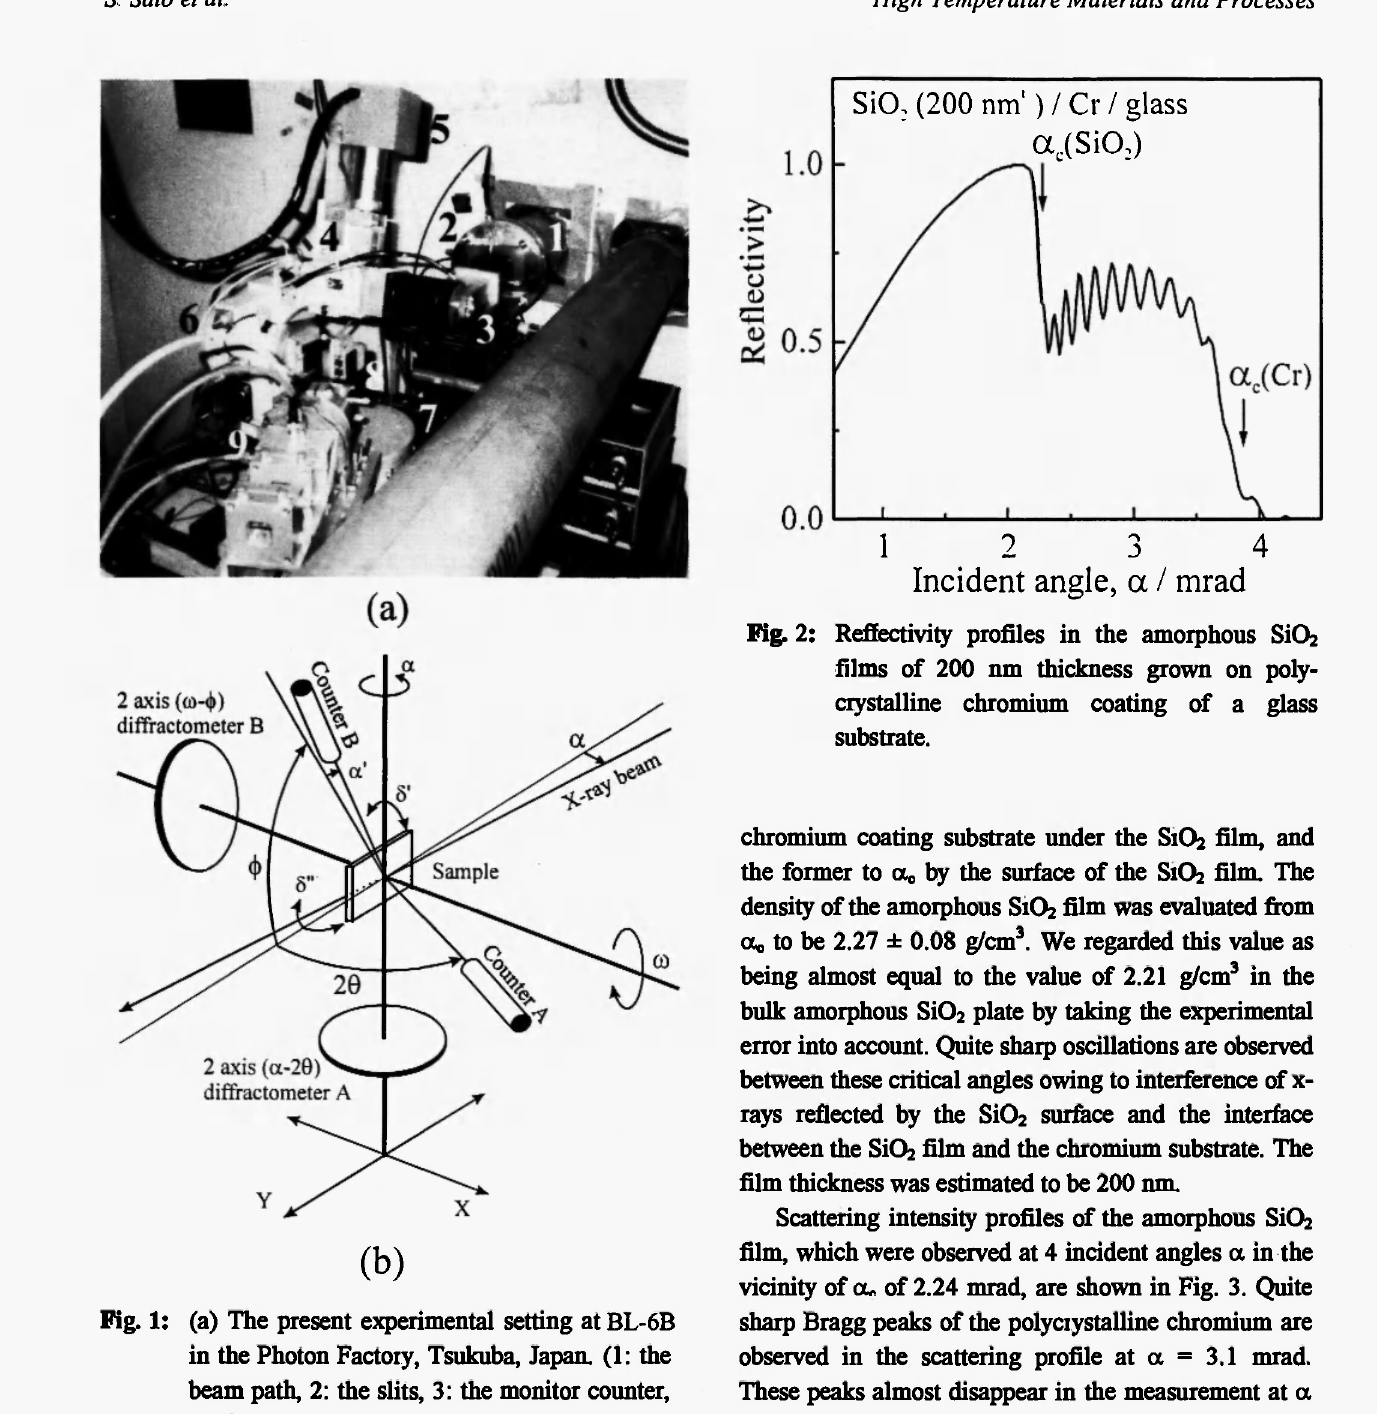
Fig. 1: (a) The present experimental setting at BL-6B in the Photon Factory, Tsukuba, Japan. (1: the beam path, 2: the slits, 3: the monitor counter, 4: the soller slits, 5: the scintillation counter (Counter Β in (b)), 6: the double axis vertical diflractometer (Diflractometer Β in (b)), 7: the double axis diffractometer (Diflractometer A in (b)), 8: the amorphous sample, 9: the ioni- zation chamber (Counter A in (b))); (b) A schematic diagram of the axial arrangements in the present GIXS diffractometer.